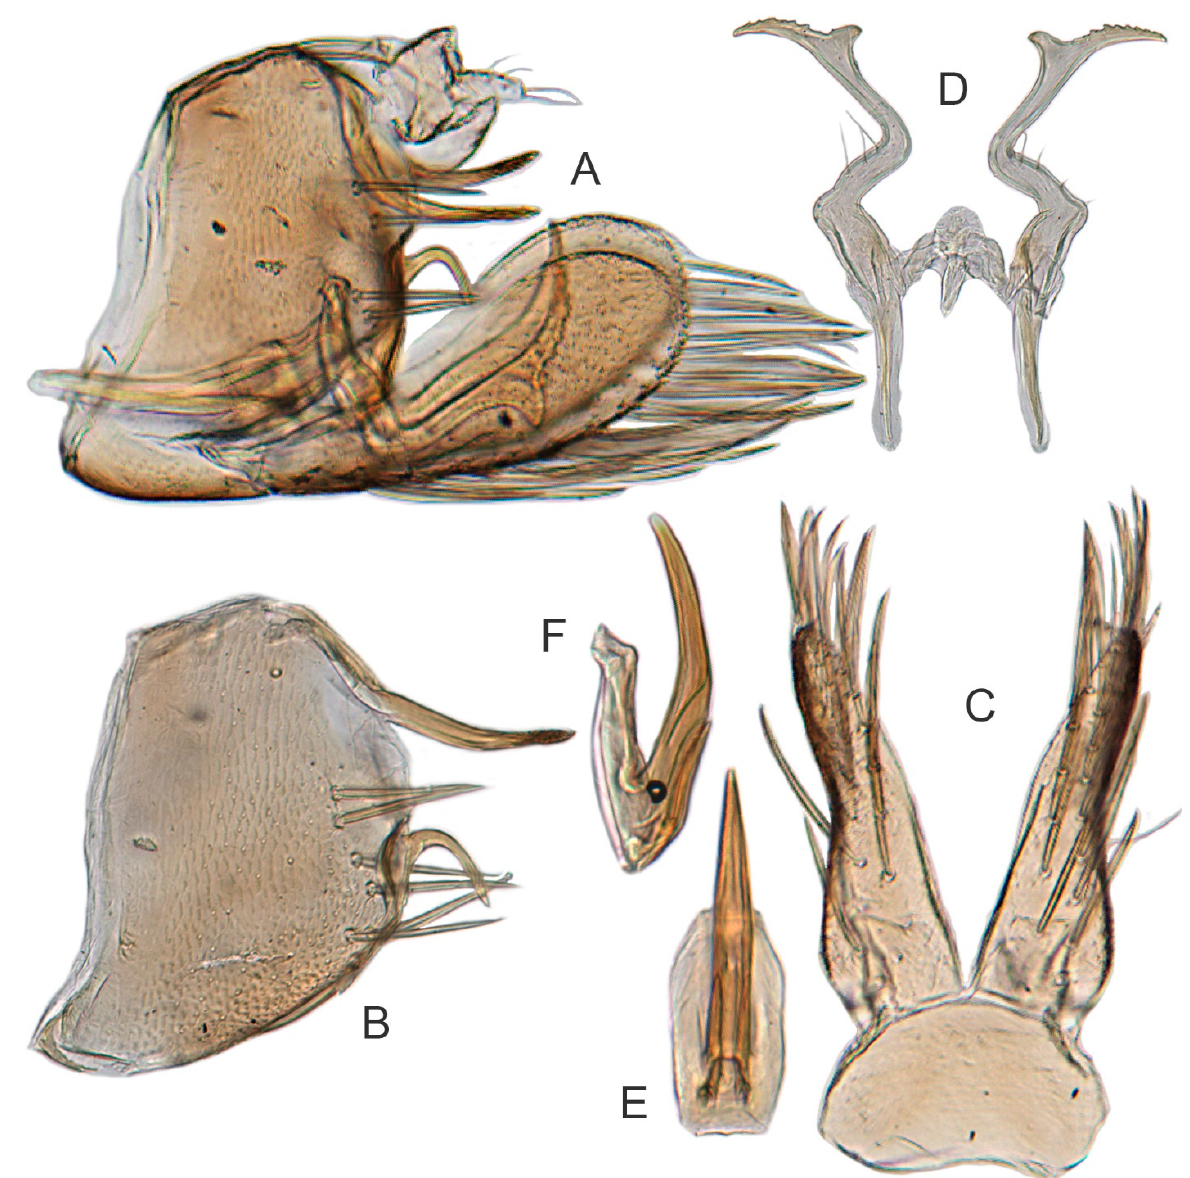
Figure 22. Xestocephalus dimiprocessus sp. nov. ( A ) Male genital capsule, lateral view; ( B ) pygofer lobe, lateral view; ( C ) subgenital plates and valve, ventral view; ( D ) style and connective, ventral view; ( E ) aedeagus, posterior view; ( F ) aedeagus, lateral view.